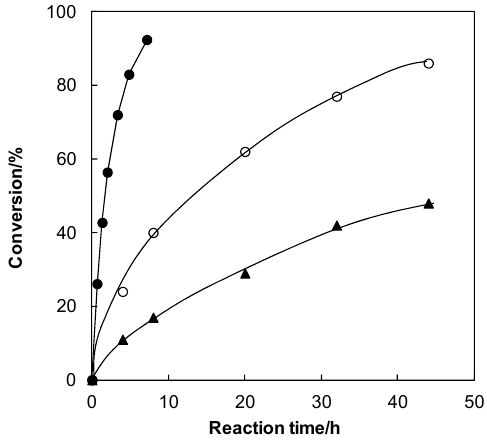
Figure 4. Kinetics of hydroperoxide 4 conversion into nootkatone 5 catalyzed with [DiC 8 ] 2 MoO 4 . ● 0.2 equiv T = 50 °C; ○ 1 equiv T = 25 °C; ▲ 0.2 equiv T = 25 °C.